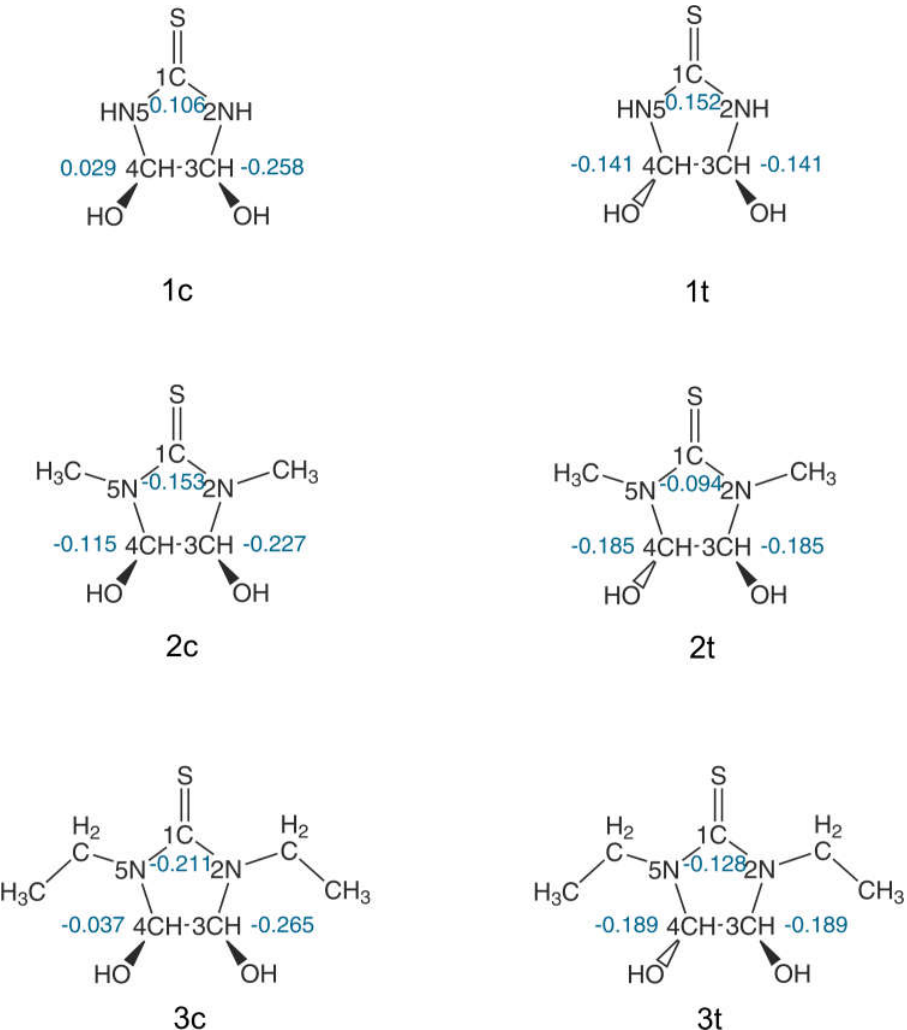
Figure 8. The calculated Mulliken charges (e) on the atoms of compounds 1–3 .